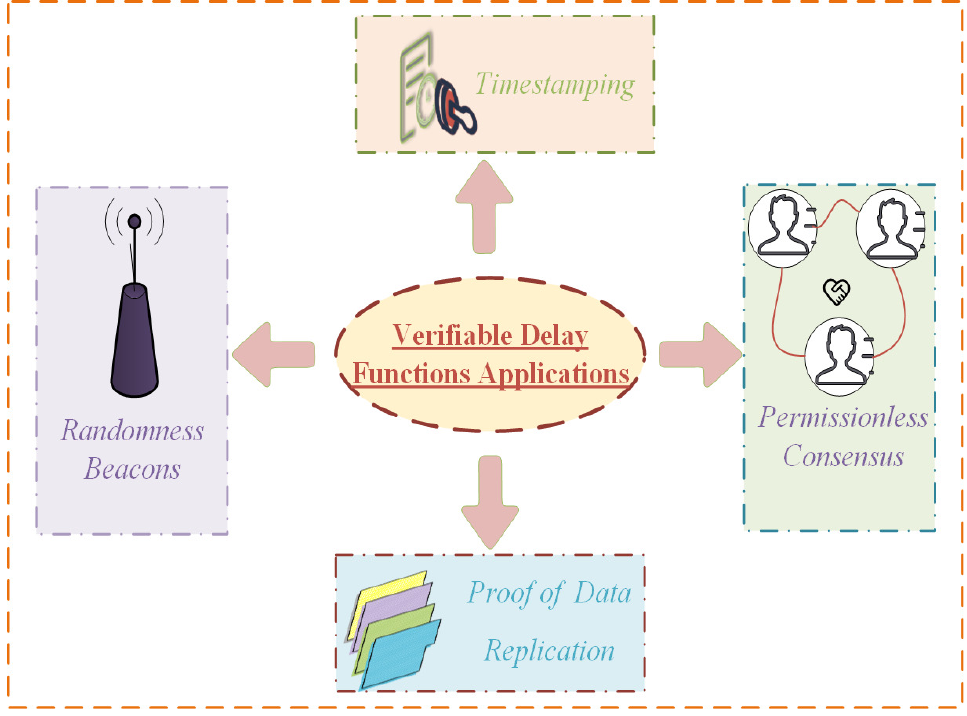
Figure 2. Verifiable delay functions